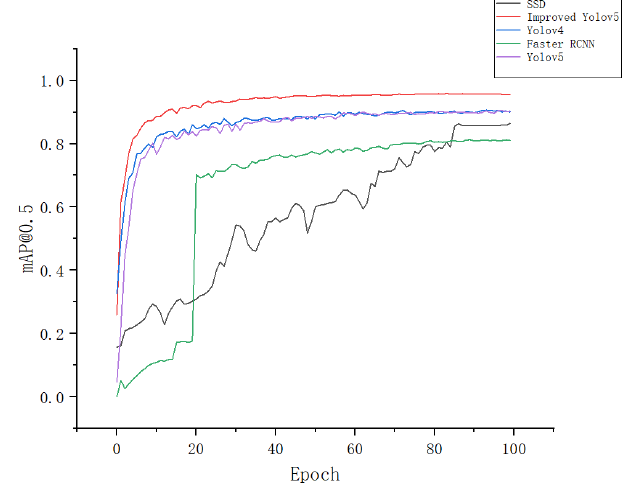
Figure 11. Accuracy variation of five object detectors.